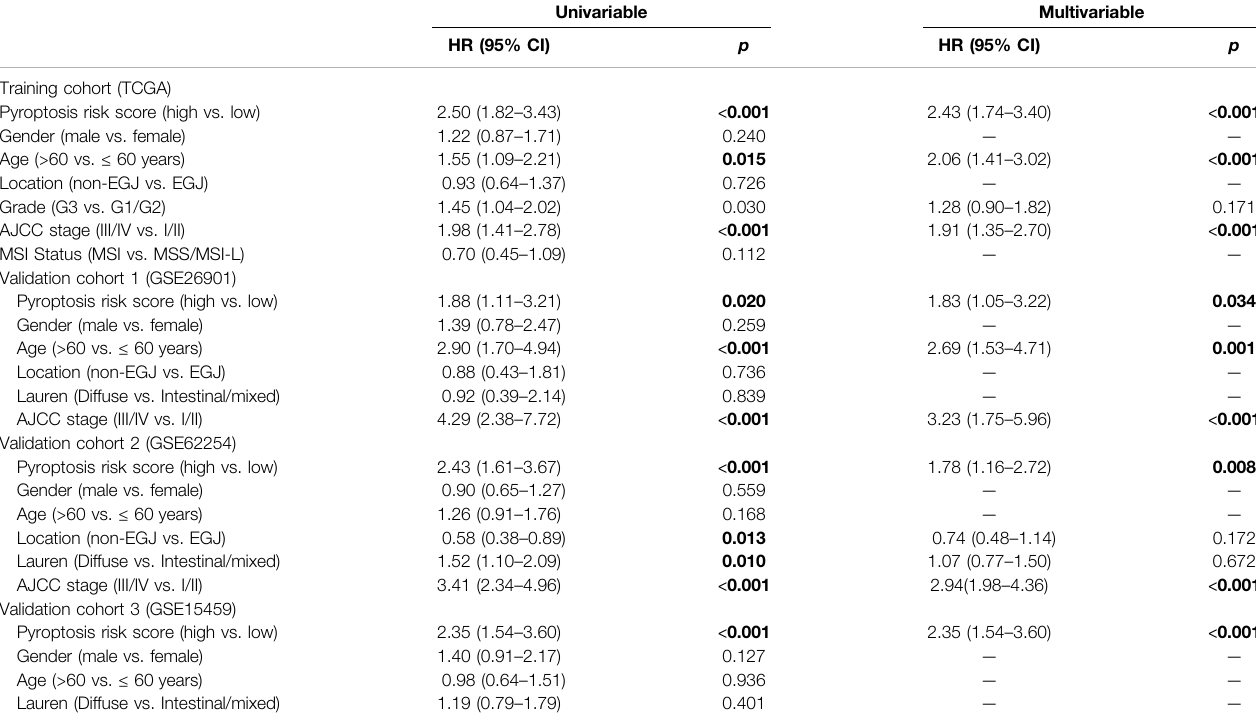
TABLE 1 | Uni- and multivariable Cox regression in the training and validation cohorts.